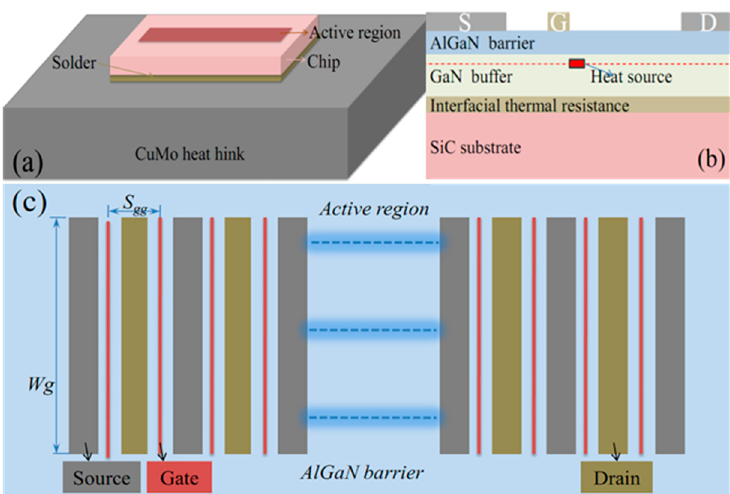
Figure 1. ( a ) Schematic diagram of the actual module for GaN amplifiers; ( b ) the cross section of chip; ( c ) the top active region.